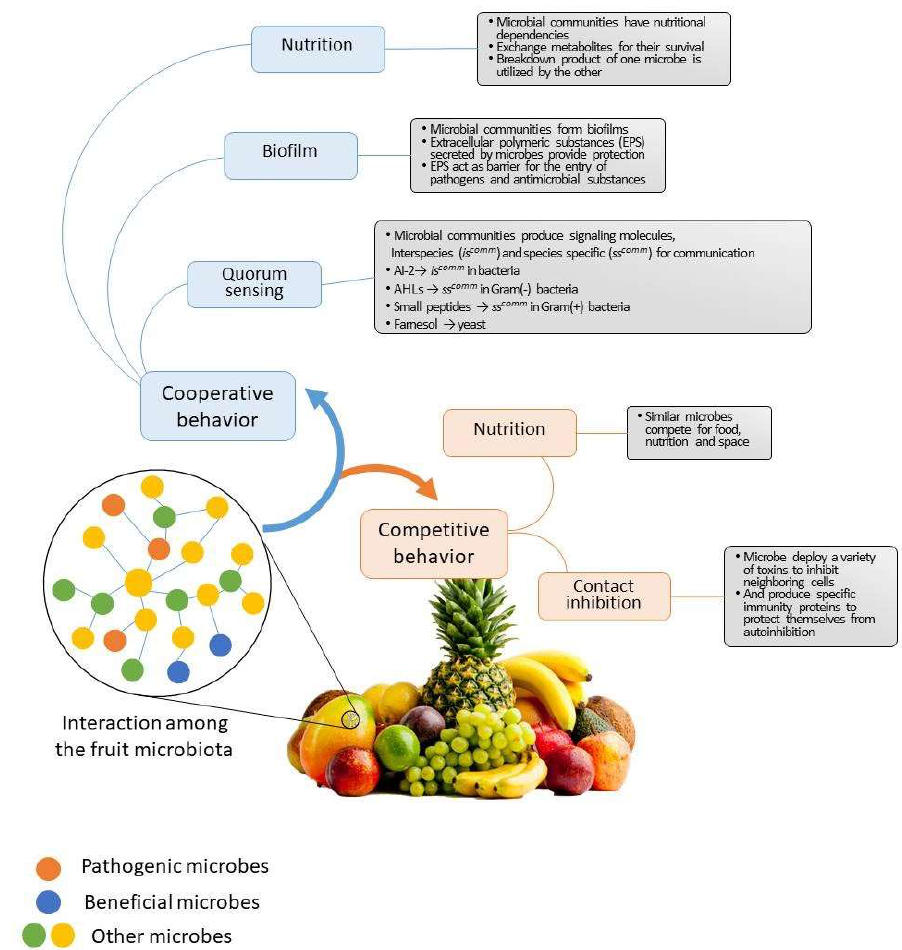
Figure 1. The cooperative and competitive behavior of microbial communities.